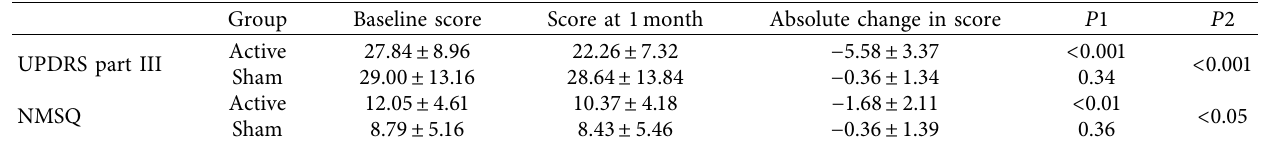
Table 2: Primary outcome comparisons between active and sham rTMS